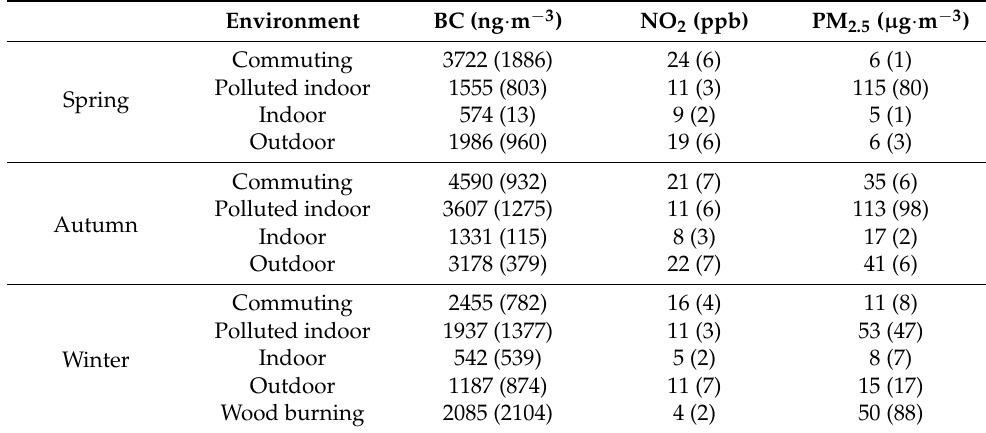
Table 3. PE mean for each environment and for each campaign (for BC, NO 2 , and PM 2.5 for all